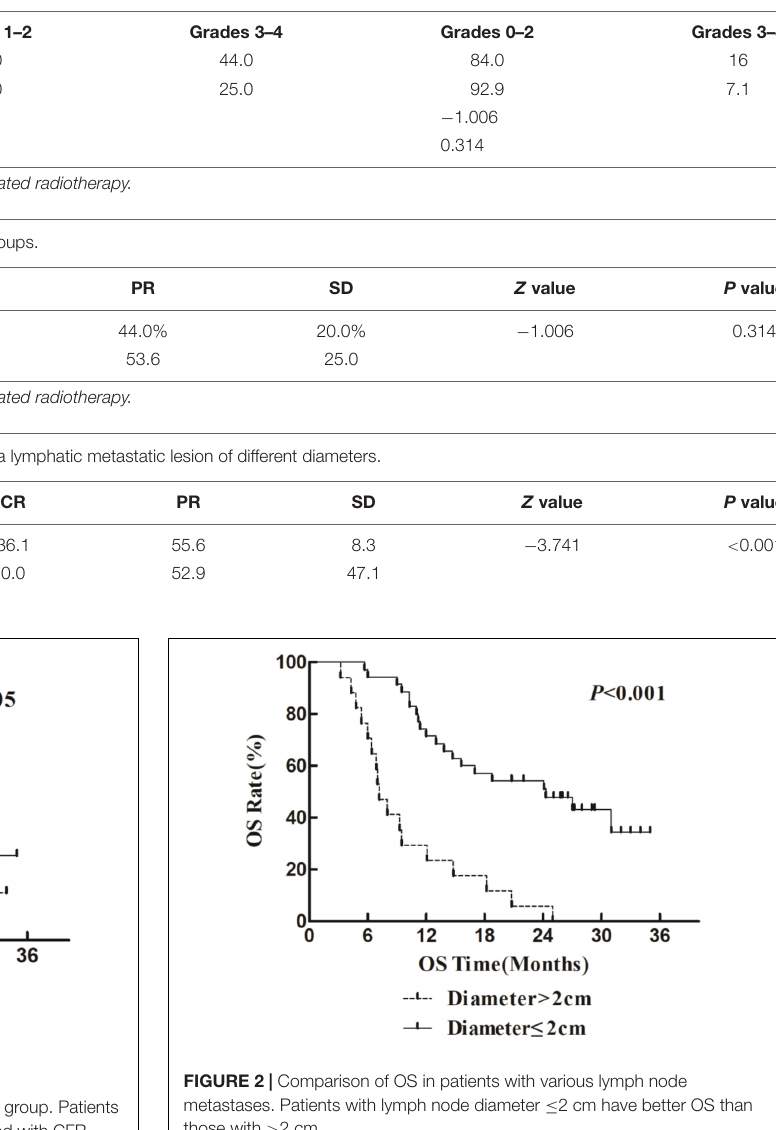
95% CI, 0.105–0.528) were independent risk factors for better